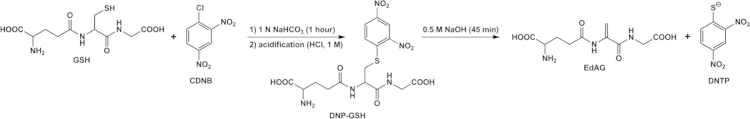
Synthesis of EdAG.